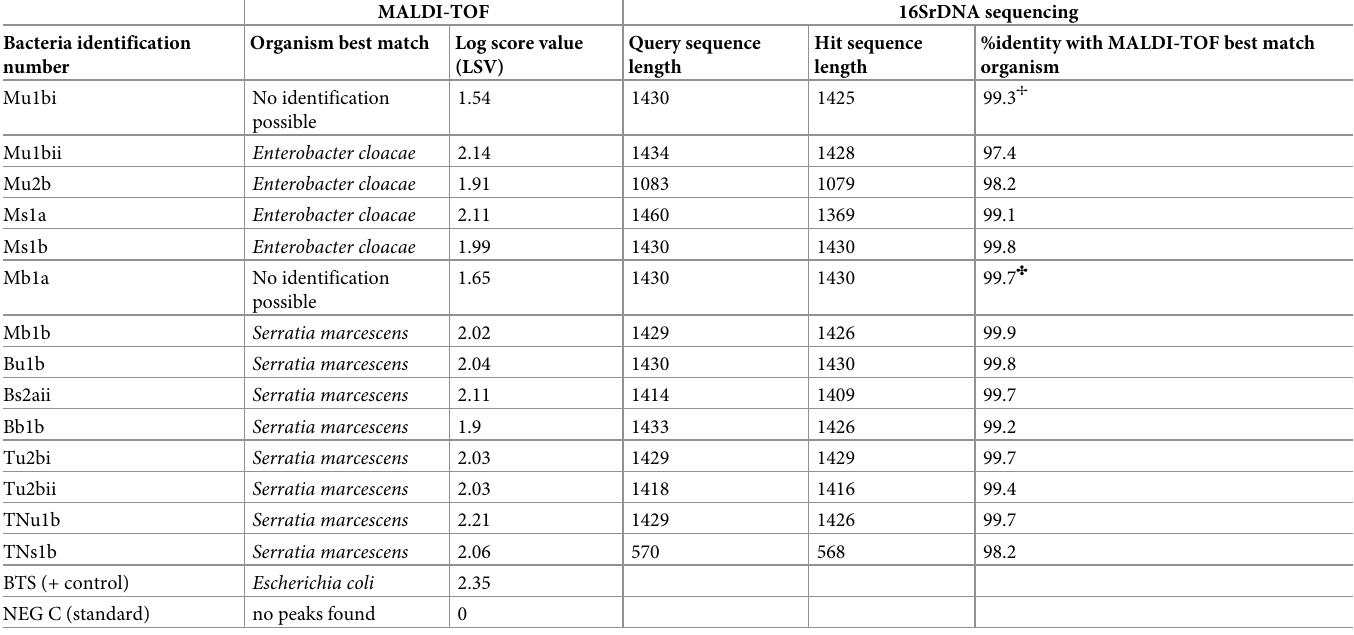
Table 1. A summary of Bruker MALDI Biotyper and 16SrDNA identification results. MALDI-TOF bacteria identity was significant if LSV � 1.9. MALDI-TOF 16SrDNA